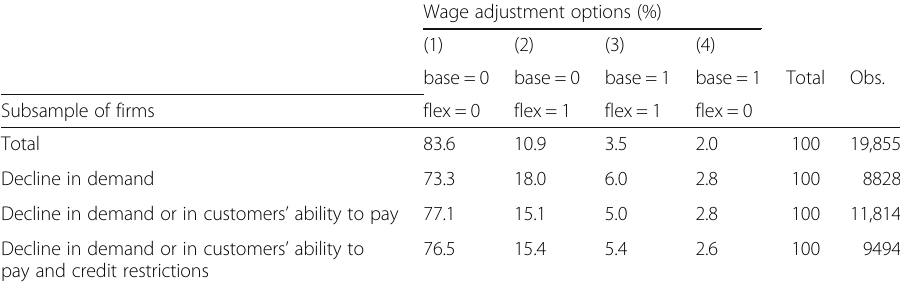
Wage adjustment options (%) (1) (2) (3) (4) base = 0 base = 0 base = 1 base = 1 Total Obs.